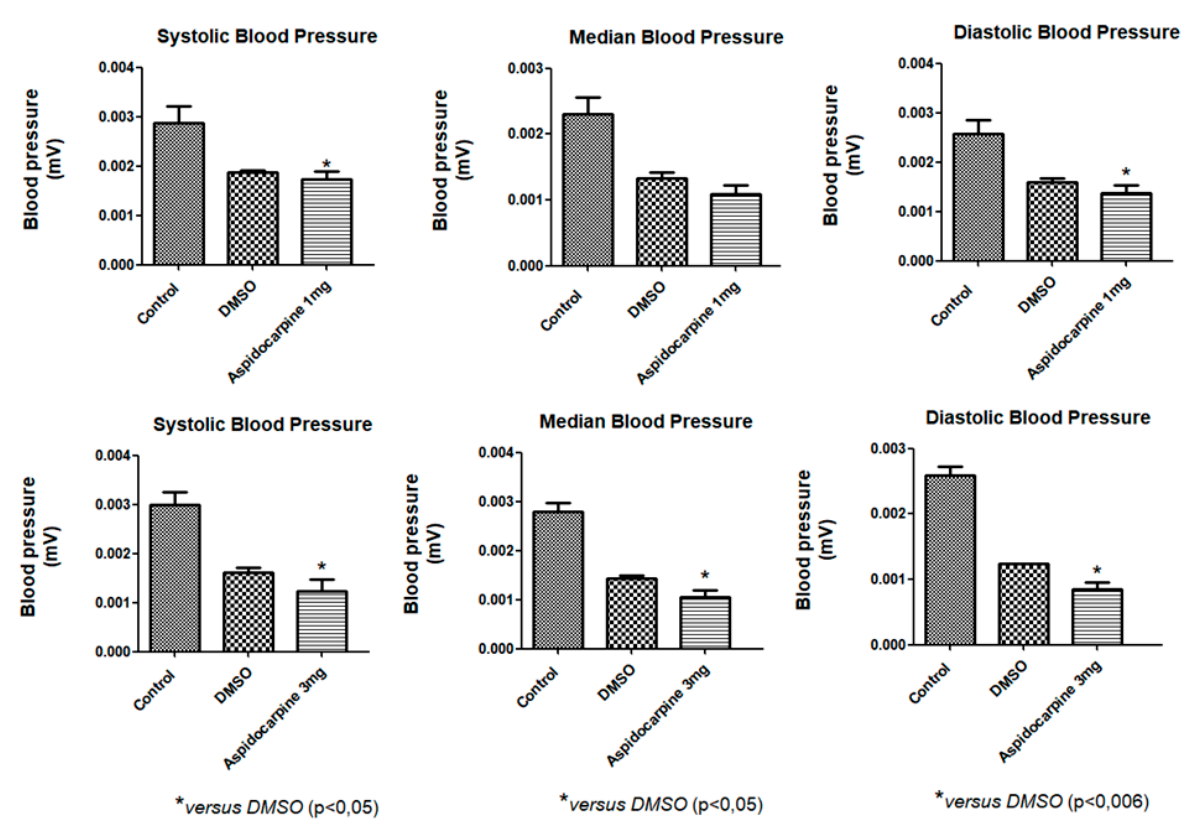
Figure 2. Effects of Aspidocarpine (1 and 3 mg/kg) on blood pressure in Wistar rats. The values are expressed as mean ± SEM ( n = 4). One-way ANOVA followed by Newman–Keuls test (* p < 0.05 compared to control).